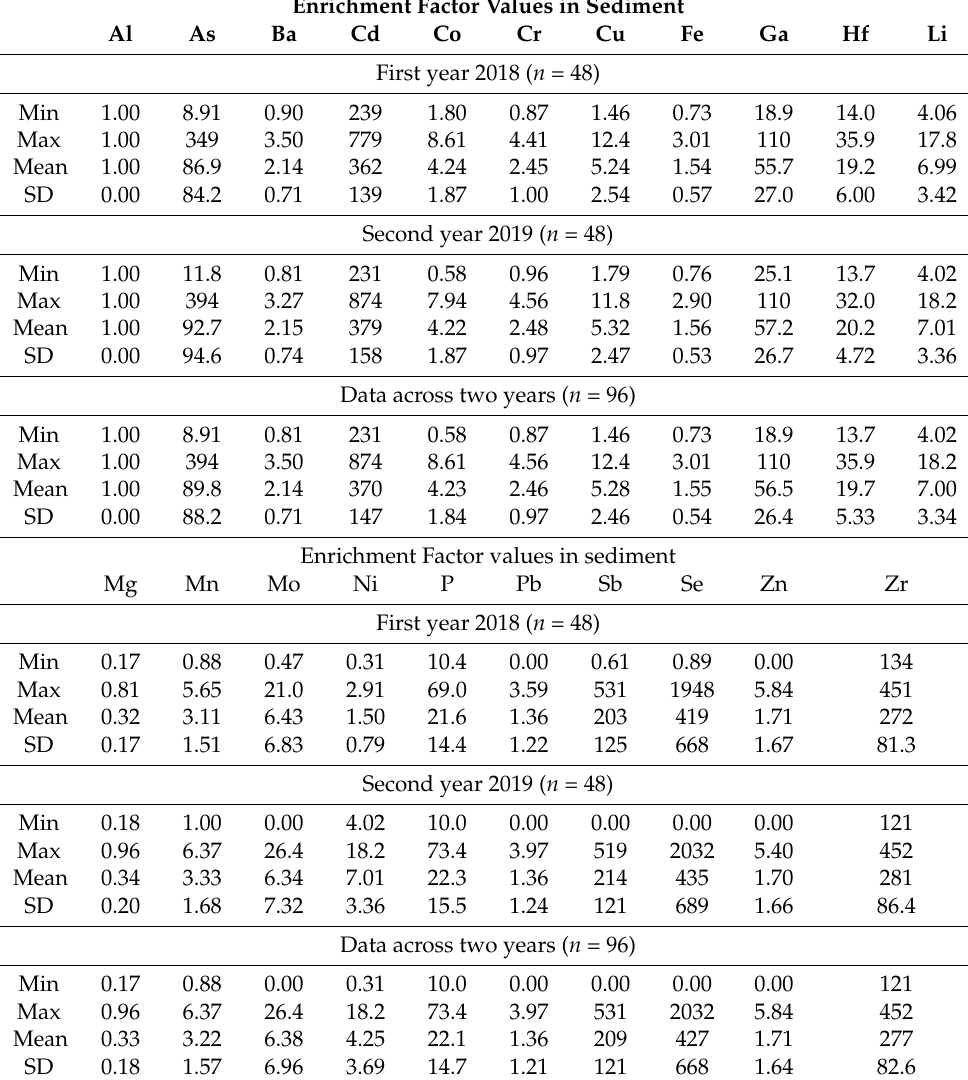
Table 4. Statistical description of Enrichment Factor (EF) in Qaroun Lake sediment over two